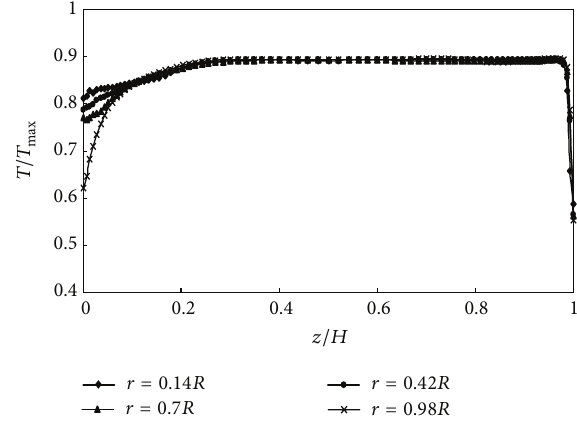
Figure 13: Profile of axial dimensionless temperature.